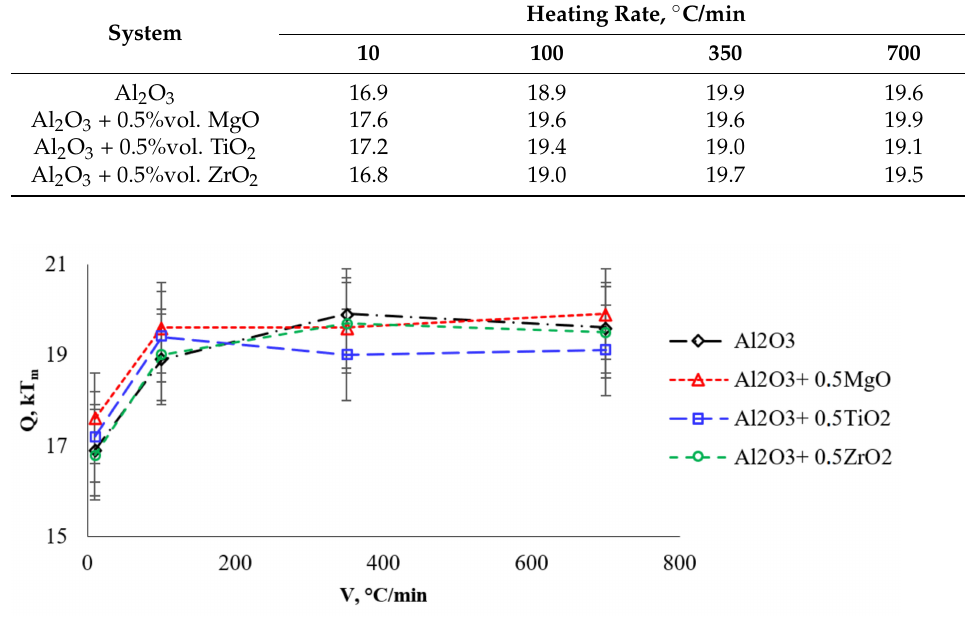
Figure 9. The dependence of Q — V on the first